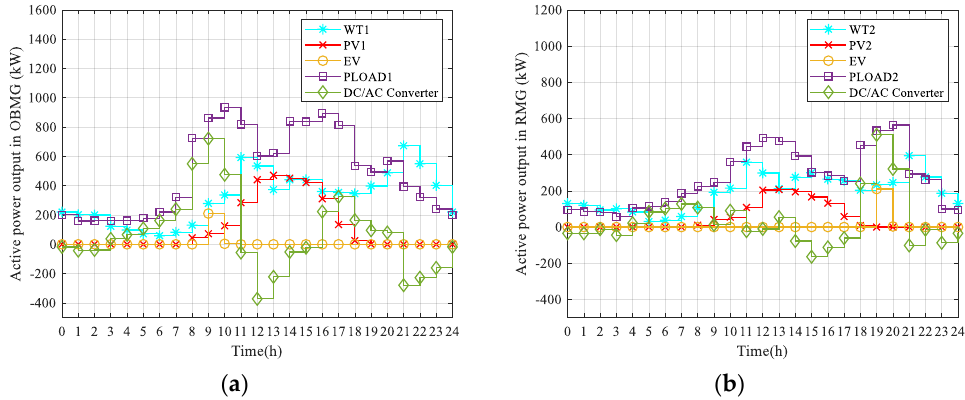
Figure 8. ( a ) Power output of RESs, EVs, and the DC/AC converter in OBMG; ( b ) power output of RESs, EVs, and the DC/AC converter in RMG.